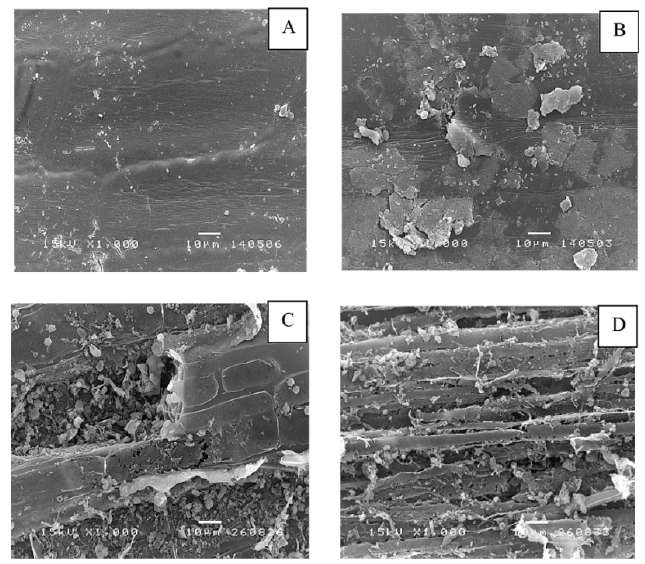
Figure 1. Scanning electron microscope of Napier grass ( A ) and silage ( B ), grass and silage after methane production (co-digestion of grass with cow dung at the ratio of 1:1 ( C ) and co-digestion of silage with cow dung at the ratio of 1:1 ( D )). Table 4. Experimental set up for methane production from a co-digestion of Napier grass with cow dung and silage with cow dung by self-fermentation at various cow dung concentrations, and a fixed substrate concentration of 10 g-VS/L.